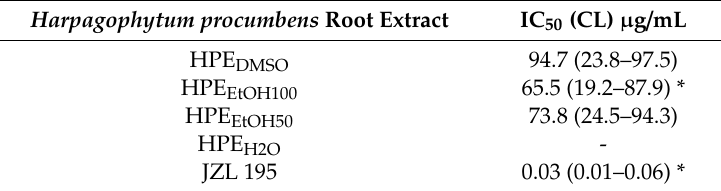
Figure 5. E ff ects of Harpagophytum procumbens root extract (HPE) on fatty acid anandamide hydrolase (FAAH) expression and enzymatic activity. ( A ) Cells were treated with 0.1 mg / mL of Harpagophytum procumbens root extract (HPE) dissolved in deionized water (HPE H2O ), DMSO (HPE DMSO ), 100% v / v EtOH (HPE EtOH100 ), and 50% v / v EtOH (HPE EtOH50 ), for 24 h. Cells were then harvested, and mRNA was extracted and analyzed by RT-PCR. FAAH mRNA levels were reported as relative mRNA expression level with respect to 18S mRNA (2 − ∆∆ Ct method). Results are expressed as mean ± S.E.M. of data obtained by three di ff erent experiments. ( B ) Concentration–response curves showing the inhibitory e ff ects on FAAH from HPE DMSO , 100% v / v HPE EtOH100 , 50% v / v HPE EtOH50 , and HPE H2O . Data are the mean ± SE of at least three independent experiments with two replicates for each experiment (n = 6). Table 4. IC 50 values of Harpagophytum procumbens root extract (HPE) dissolved in DMSO (HPE DMSO ), 100% v / v EtOH (HPE EtOH100 ), 50% v / v EtOH (HPE EtOH50 ), and deionized water (HPE H2O ) and the positive control JZL 195 in the FAAH inhibition